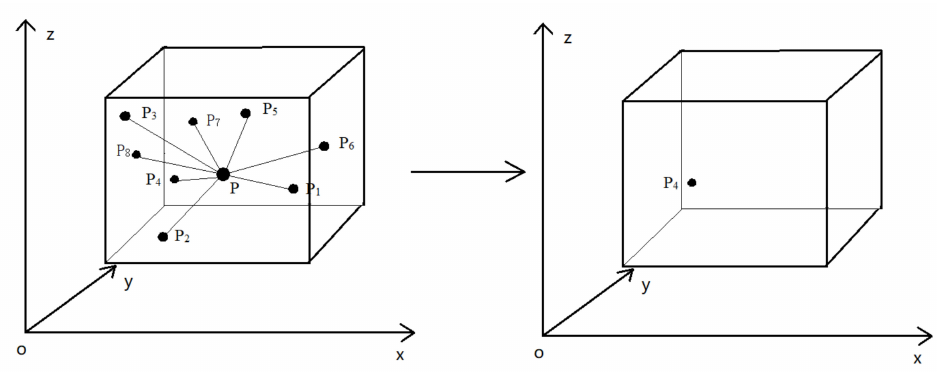
Figure 4. Simplification profile based on the regional gravity center.